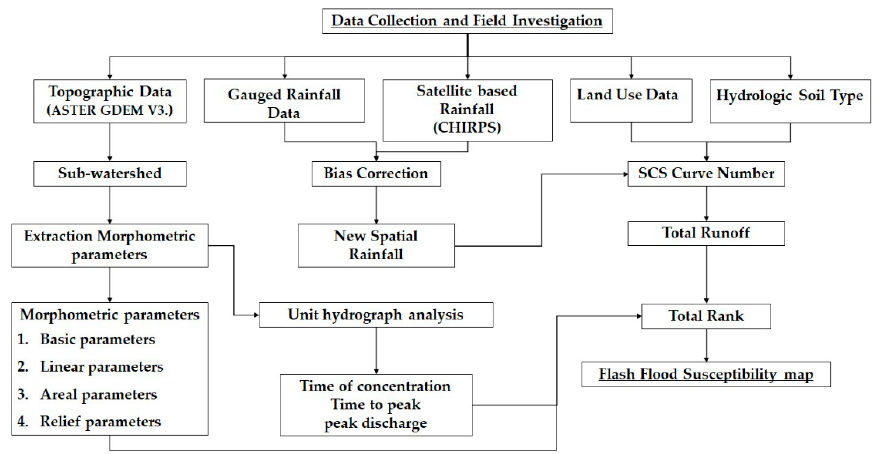
Figure 2. Schematic of the methodology used in the study.